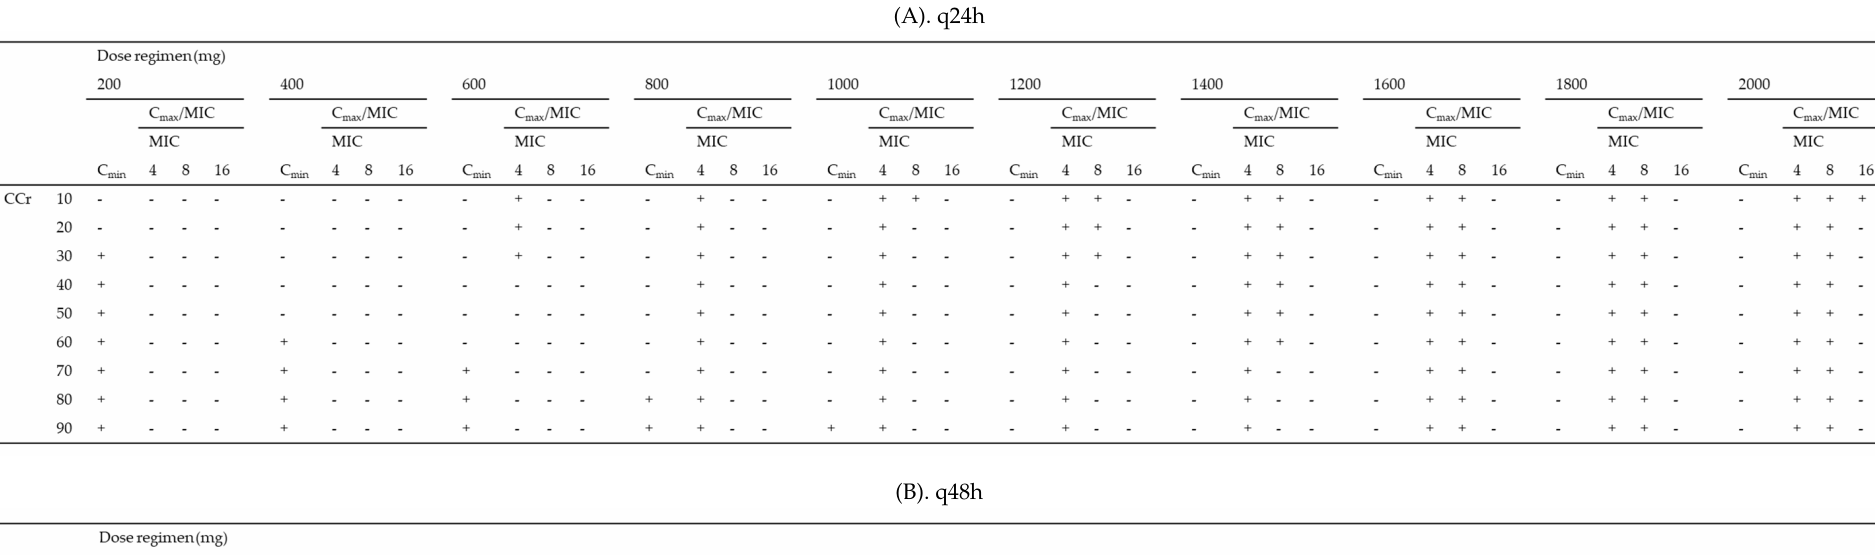
Table 3. Monte Carlo simulations and probability of target attainment (PTA) of toxicity (Cmin < 4 mg/L) and efficacy (Cmax/MIC ≥ 8) against an MIC of 4 mg/L for various